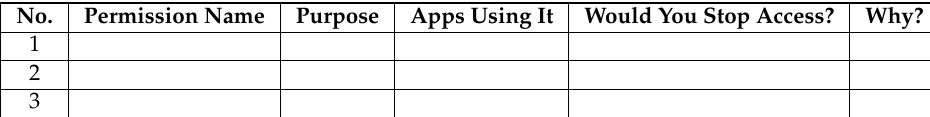
Table A5. This form was used for Activity 8 (only for the second